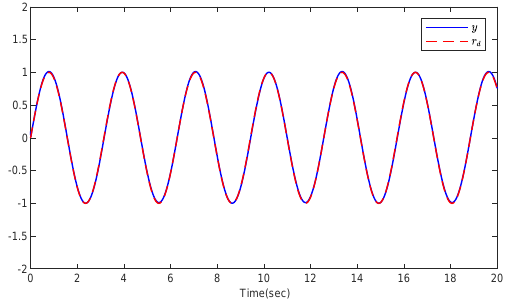
Figure 6. The trajectories of y and r d .